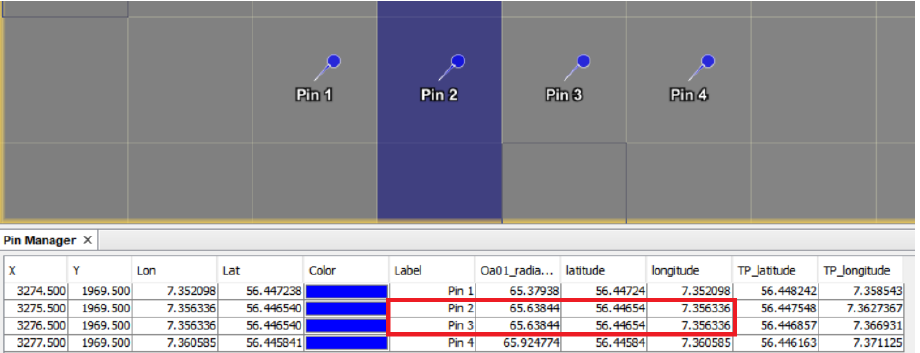
Figure 1. An OLCI image viewed with zoom in SNAP. Squares—single pixels, the blue stripe— quality_flags_duplicated mask. The pins demonstrate that the duplicated pixel (Pin 2) copies radiance and geo-coordinates (but not tie-point (TP) coordinates) from the nearest pixel (Pin 3). Duplicated pixels occur very often (23% of any OLCI